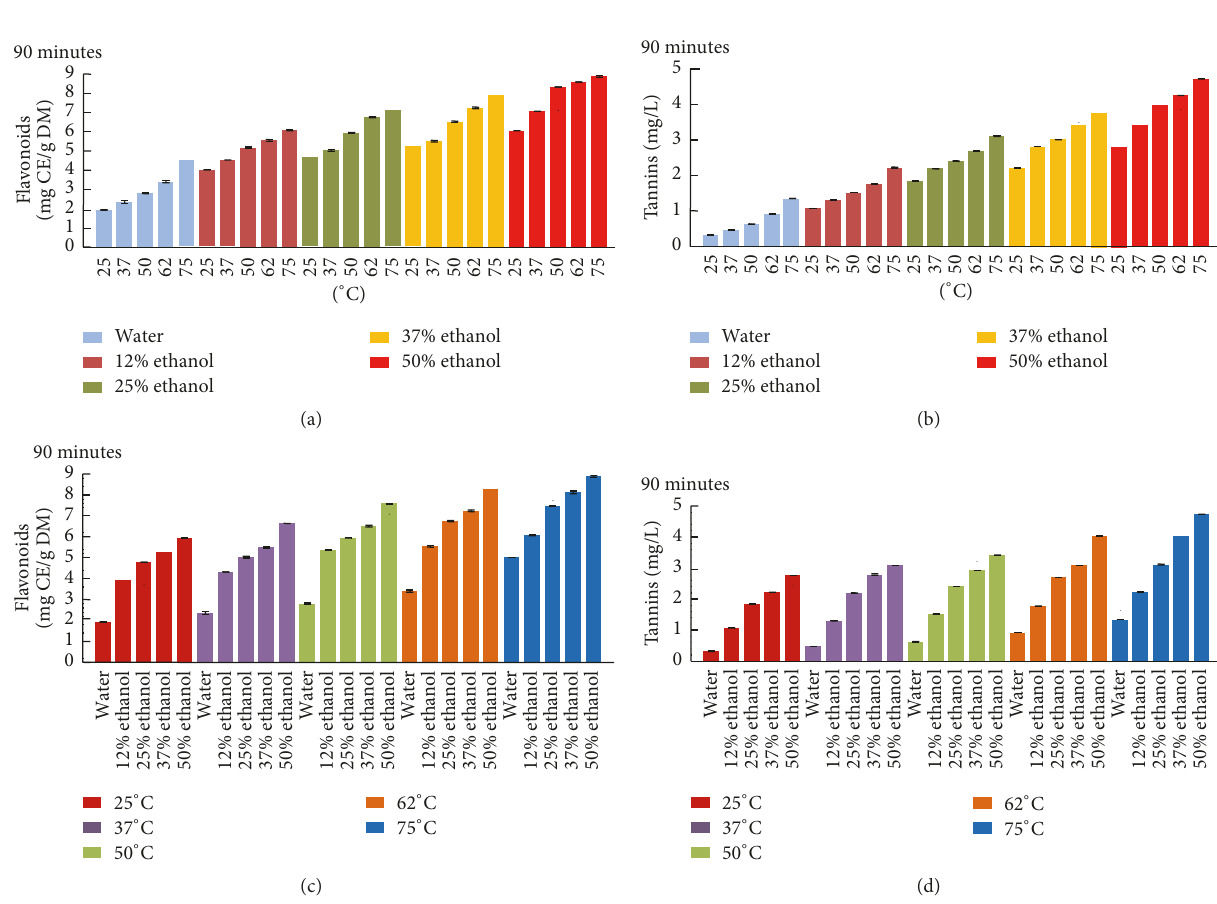
Figure 4: Flavonoids (a, c) and tannins (b, d) recovery of apricot pomace extracts at 90